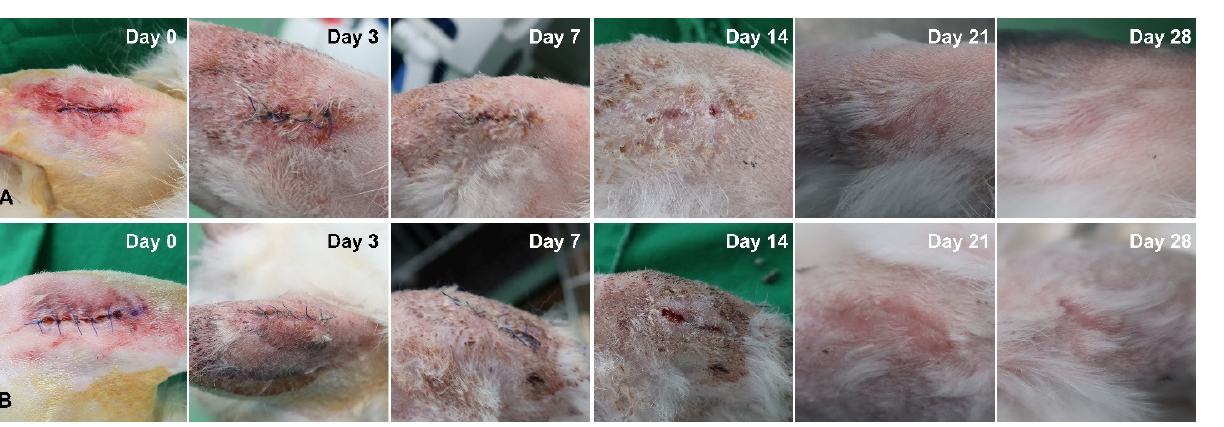
Figure 6. Comparison of soft tissue healing after laser incision between two groups. ( A ) Multi-laser handpiece system (experimental group). ( B ) Conventional laser handpiece system (control group).